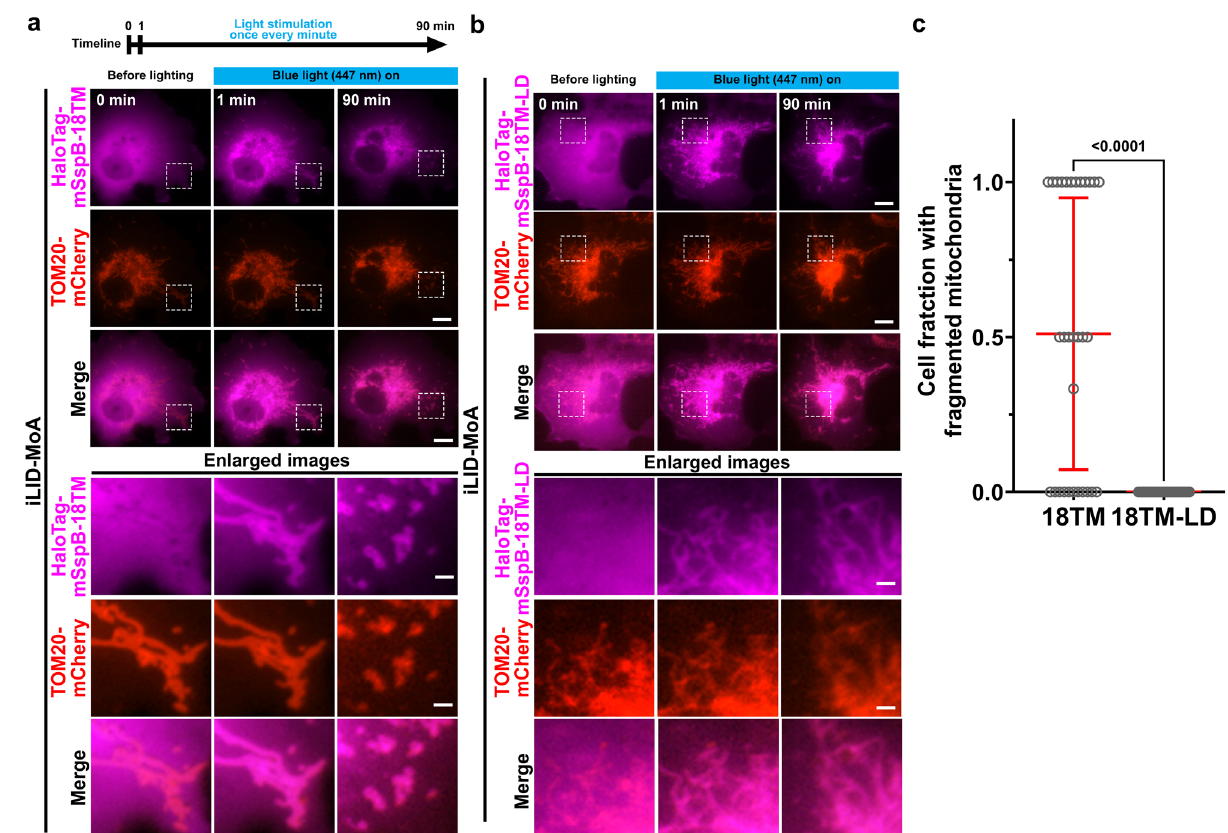
Fig.5|Optogeneticcontrolof18TM-mediatedmitochondrialdeformation.a,b Time-lapse fl uorescence images of COS-7 cells transfected with HaloTag-mSspB- 18TM ( a ) or HaloTag-mSspB ( b ) along with iLID-MoA (a mitochondrial anchor) and mCherry-MoA (an indicator of mitochondria morphology). The cells were illumi- natedbybluelightat447nm(bluebarsontop).TheHaloTag-mSspBwasvisualized with a JF646-conjugated HaloTag ligand which was incubated for 30min before onset of the imaging. Areas marked by dashed-line boxes are magni fi ed at the